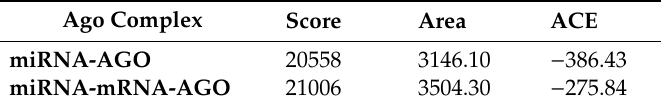
Figure 11. The amino acid residues of human argonaute protein participating in the binding analysis with each mRNA and microRNAs within a distance of 3.5 Å. ( A ) Amino acids participating in miR-195-5-AGO complex, ( B ) amino acids participating in miR-195-5p-CHEK1 duplex and AGO. Table 4. Docking scores (PatchDock).